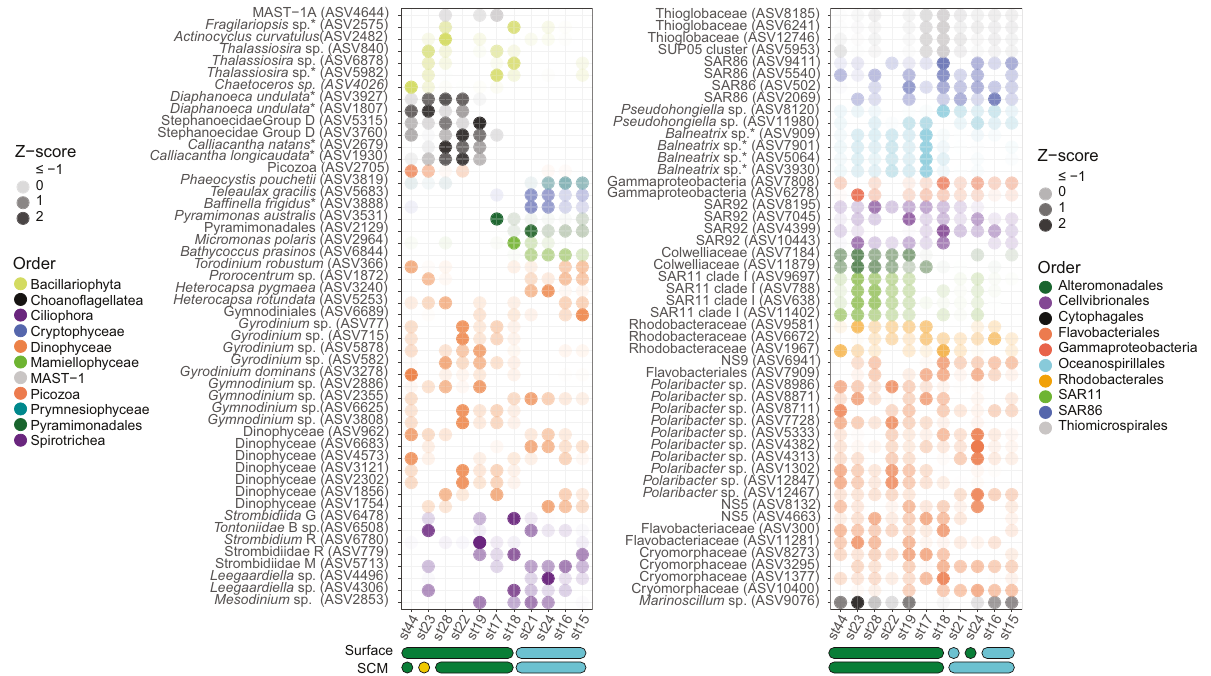
Fig. 4 Heatmap of the 50 most abundant ASVs at surface and SCM layers. For each ASV, the Z-score shows the deviation from the mean relative abundance (Z-score = ASV relative abundance − mean relative abundance/standard deviation). The fi ll color of the circles corresponds to order level classi fi cations. The color shapes at the bottom of the fi gure show clusters from Fig. (Fig. 4). ASVs related to Balneatrix (ASVs 909, 7901, 5064 and 3930), SAR11 clade Ia (ASVs 9697, 788, 638 and 11402), unclassi fi ed Colwelliaceae (ASVs 7184 and 11879) and Polaribacter (ASVs 8986, 7728, 1302, 12847) were more abundant in the open water of northwestern HB. By contrast, ASVs af fi liated to Pseudohongiella (ASVs 8120 and 11980), SAR86 (9411, 5540, 502, 2069) and Flavobacteriaceae NS9 (ASV 6941) were more abundant in Central HB, together representing 2.7% of the reads. Several representa- tives of SAR92 also showed different preferences for the open water (ASVs 8195, 10443) or ice-edge (ASVs 7045, 4399) conditions. At 70 m and bottom depths in the rDNA dataset, the top 50 ASVs accounted for an average of 60.6 ± 11.1% of the total ASVs for eukaryotes and 62.4 ± 15.2% for prokaryotes (Supplementary Fig. S6). At these depths, pelagic diatoms such as Thalassiosira (ASVs 840, 6878, 5450 and 5631) and Chaetoceros (ASV 4026) were relatively more abundant in northwestern HB, together reaching